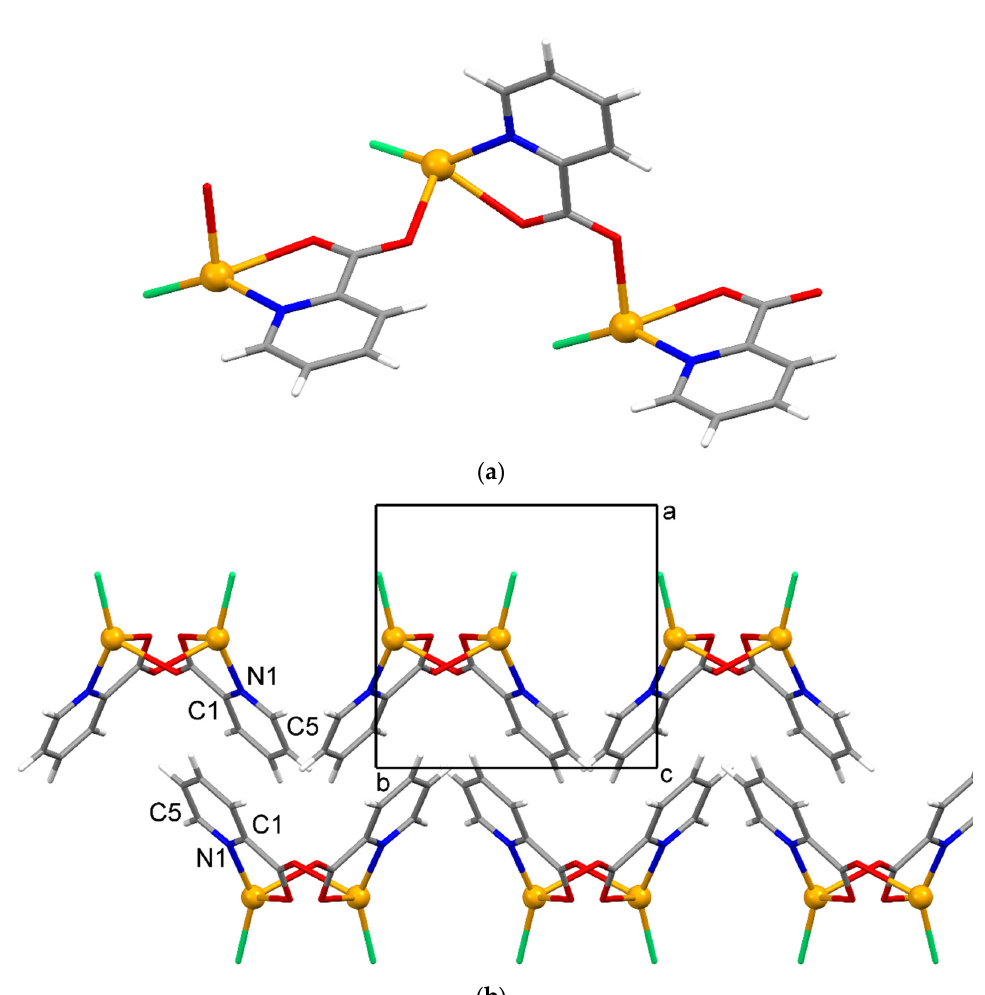
Figure 2. The infinite one-dimensional polymeric zigzag chain of {[HgCl(pic)]} n ( 1 ) extending along the [0 0 1] direction ( a ). A fragment of the structure of {[HgCl(pic)]} n ( 1 ) viewed down the [0 0 1] direction. The polymeric chains, represented as monomeric molecules in this projection, are connected along the [0 1 0] direction by π – π interactions between symmetry-related picolinate pyridine rings (N1/C1–C5); the selected atoms of the pyridine rings in the interactions are labeled ( b ).